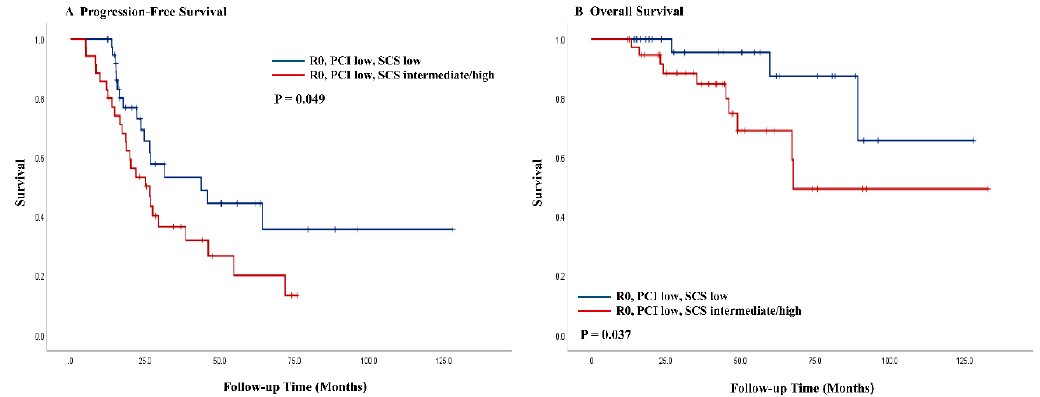
Figure 4. Kaplan–Meier curves of progression-free ( A ) survival and overall survival ( B ) stratified by surgical complexity score in no residual disease patients with low disease burden before